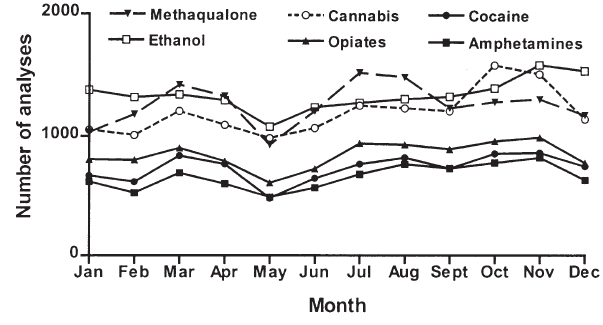
Fig. 1. Total number of analyses for substances of abuse per month (1991 - 2002).